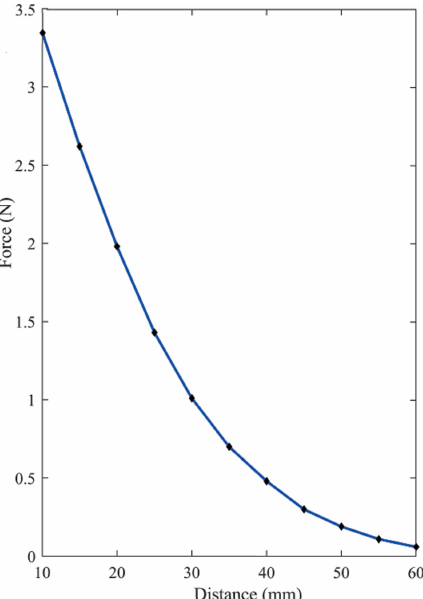
Figure 2 Comparison of the gap-dependence of the magnetic force. Experimental values and a fitting curve are shown by black dots and the blue solid line, respectively.